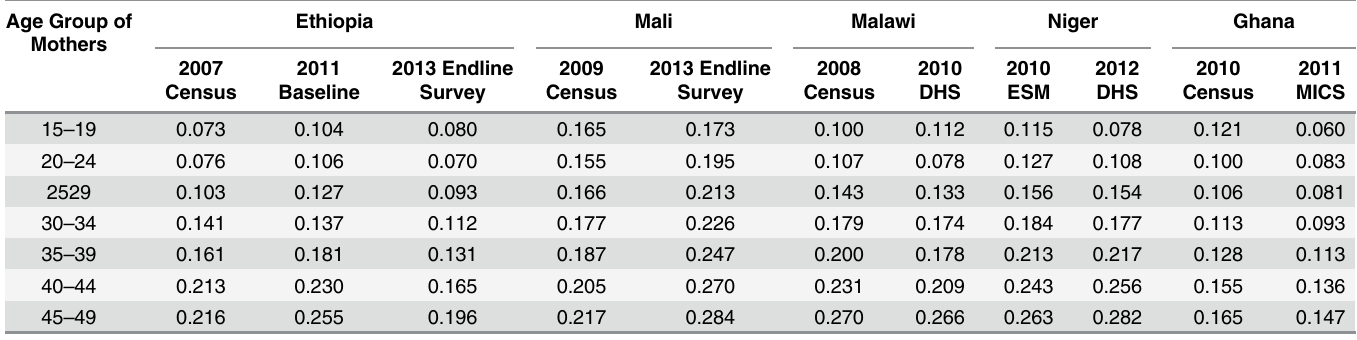
Table 3. Proportions Deceased of Children Born Reported by All BHI and Comparison